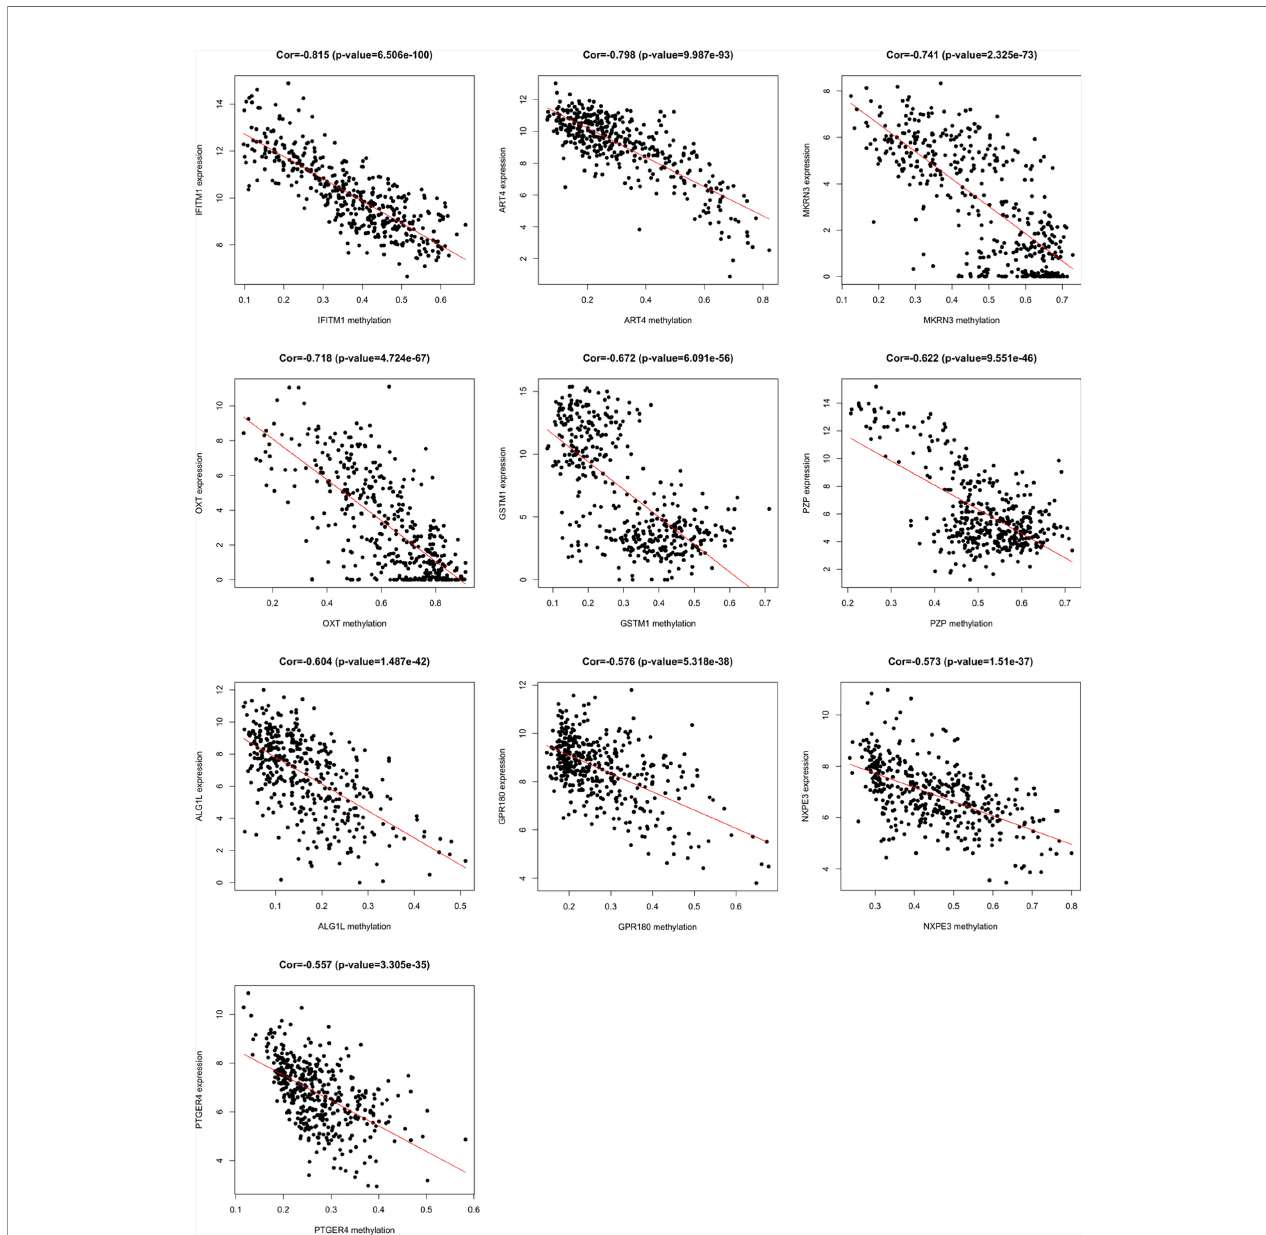
FIGURE 3 | Methylation-regulated differentially expressed genes (MeDEGs) with the top ten correlation coef fi cients. Spearman ’ s correlation analysis for methylation (horizontal axis) and expression (vertical axis) of MeDEGs. Spearman ’ s correlation coef fi cient and P-values are shown in each